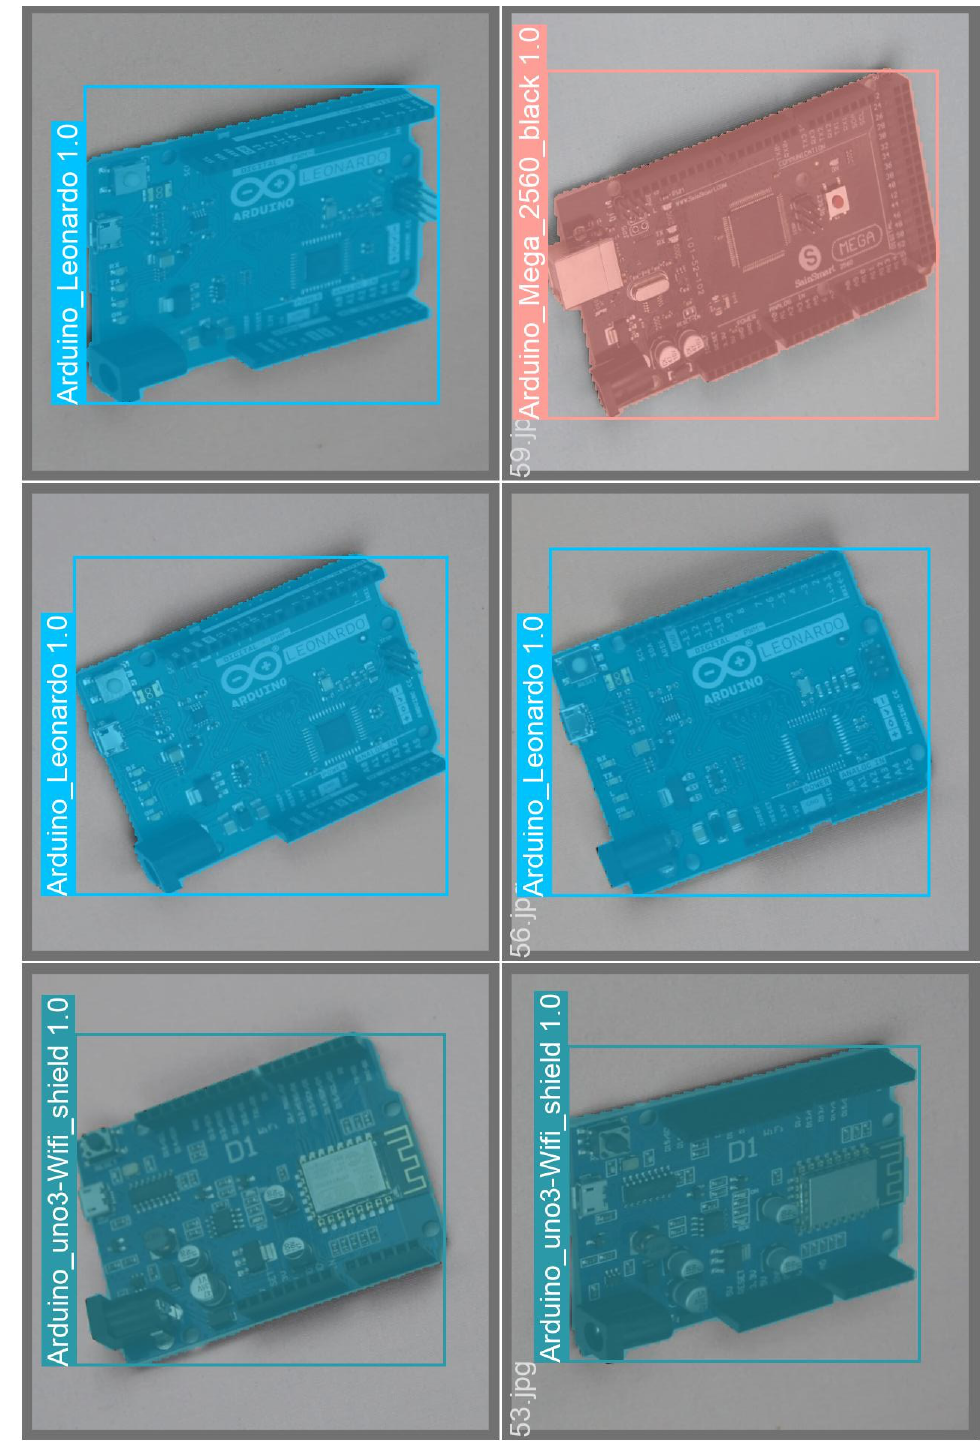
Figure A4. Intended classes of the second